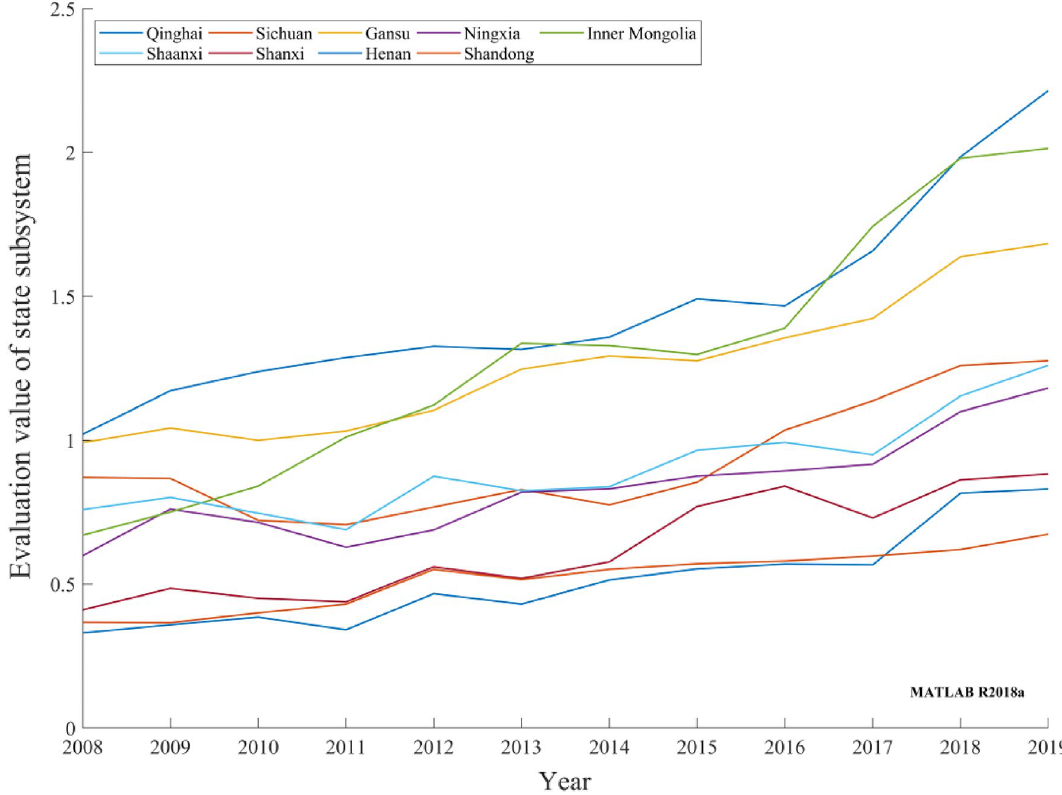
Figure 5. Evaluation values of provincial carbon-neutral state subsystems in the Yellow River basin during